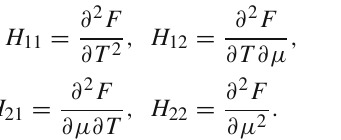
Fig. 2 Specific heat in terms of r h . We set unit value for all model parameters except θ = 10, d = 8. α = 0 . 5, γ 1 = 0 ( red dash ), α = − 0 . 5, γ = 0 ( red dot ), α = 0, γ 1